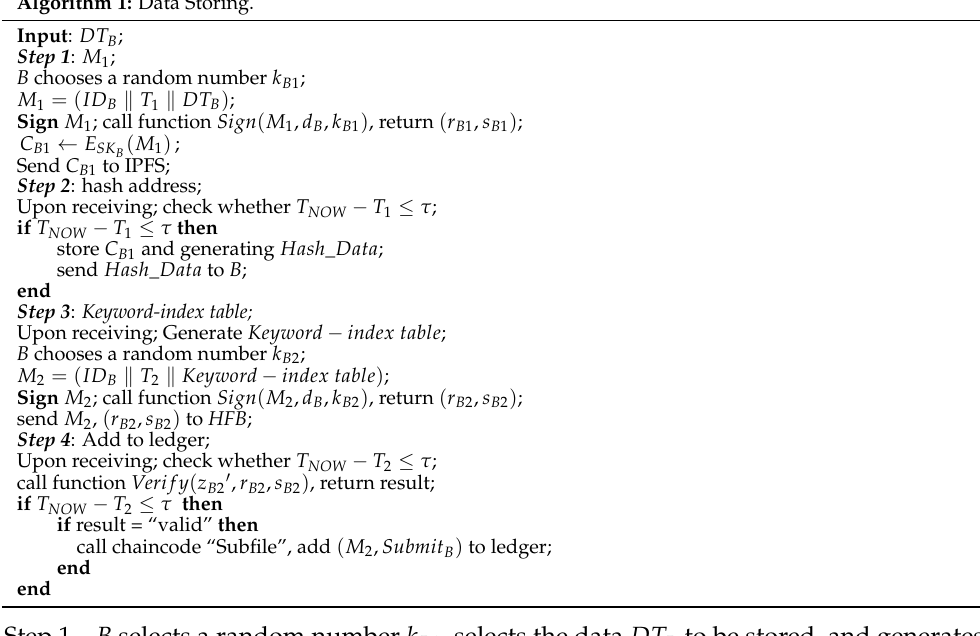
Figure 4. Keyword-index table structure. Algorithm 1: Data Storing.